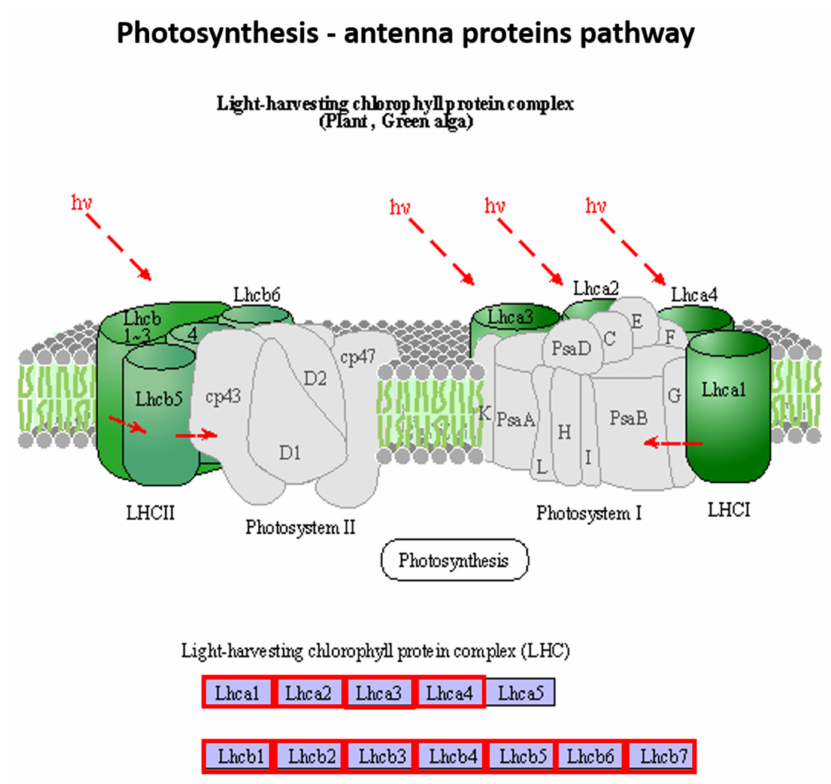
Figure 3. DEGs involved in photosynthesis-antenna proteins pathway of the blanched stem (pre vs. post-blanching) of water dropwort. Red color boxes indicate the downregulated genes [12,13].